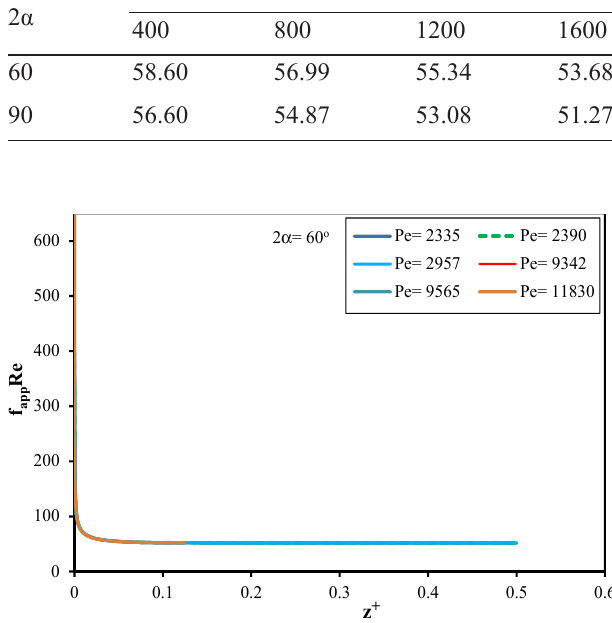
Fig. 8. The f app Re of nanofluids vs. axial position for different Peclet numbers.